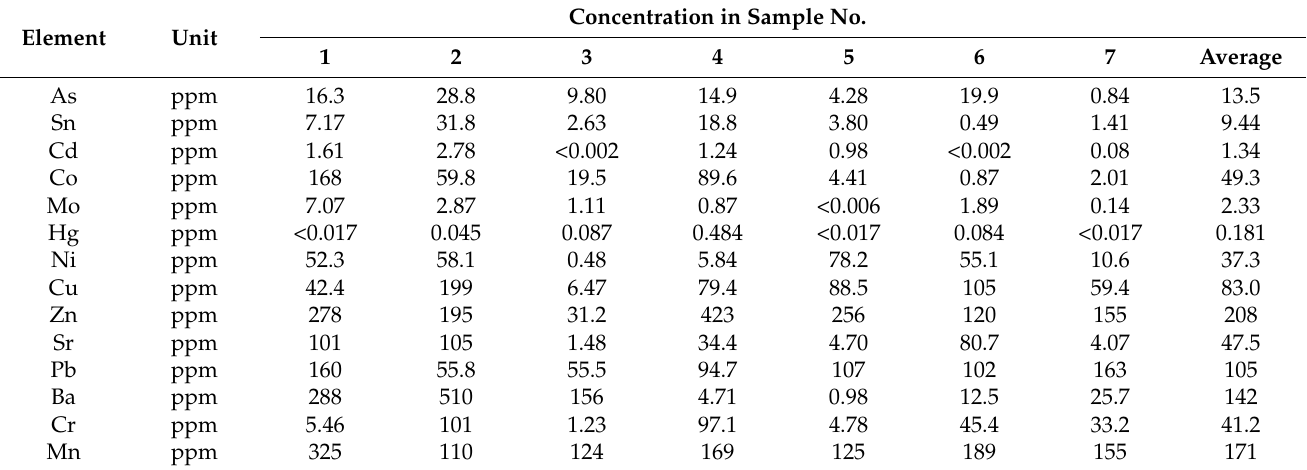
Table 1. Concentrations of Trace Elements in Waste